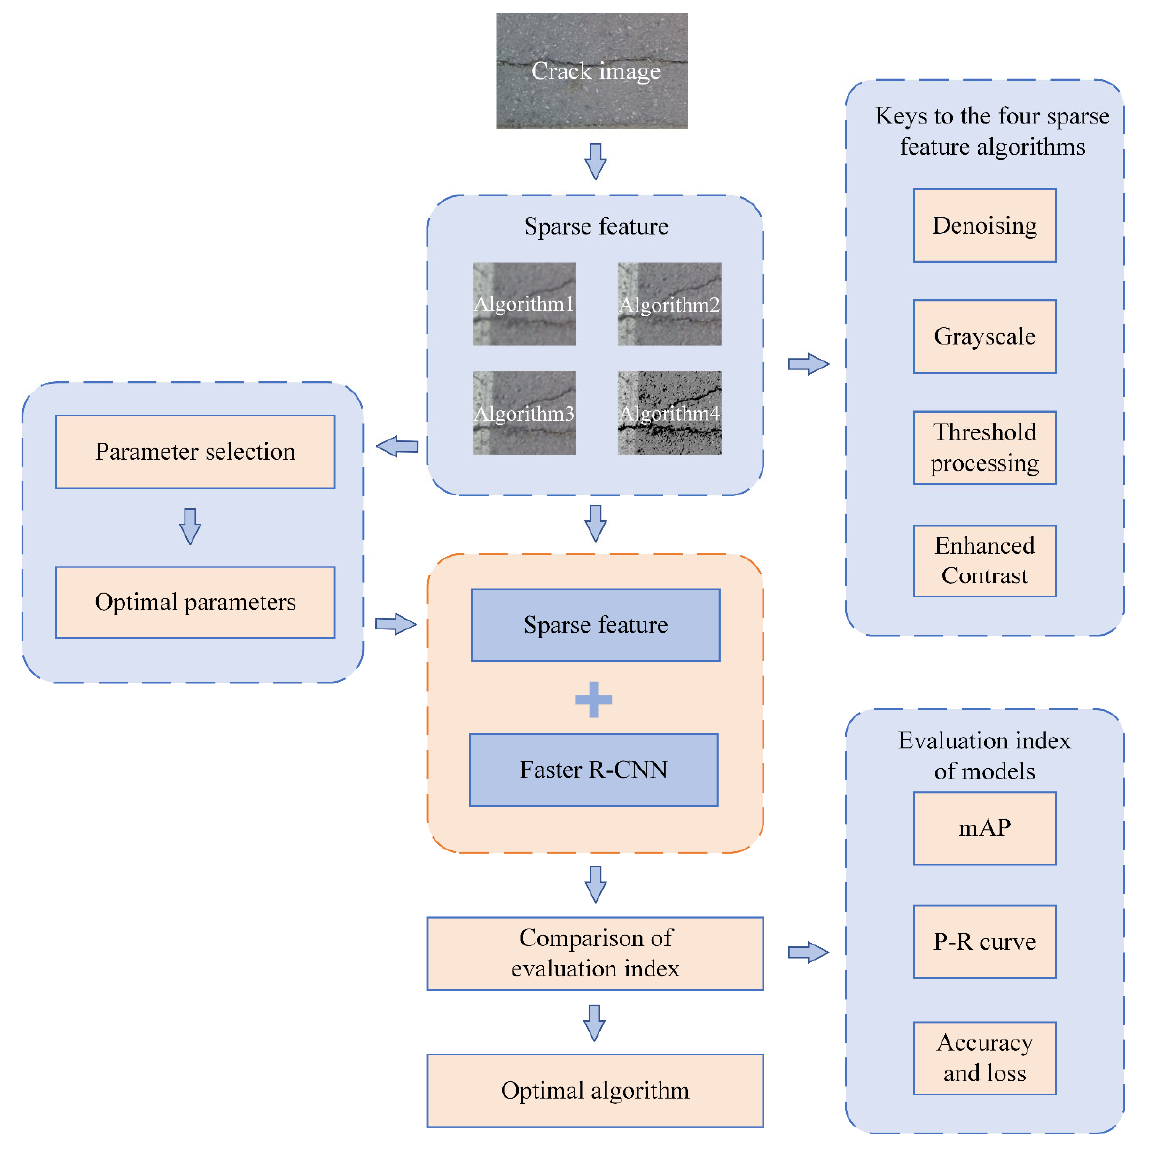
Figure 1. Pipeline of our